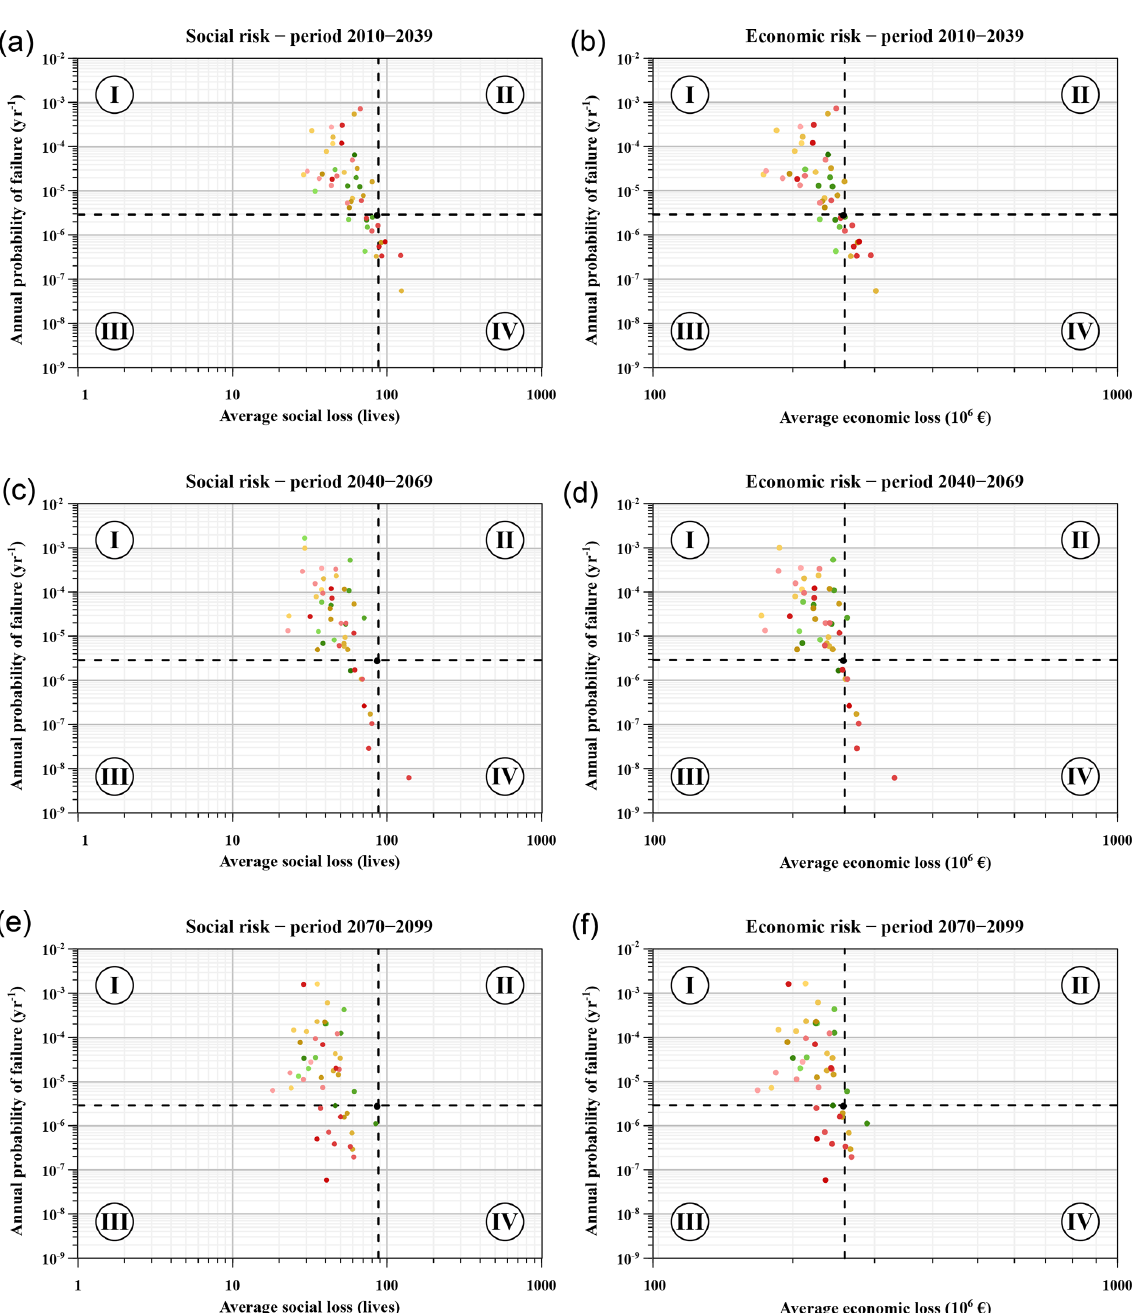
Figure 12. Disaggregation of social and economic risks ( a–f ) in annual probability of failure and average consequences, classified by simulation period. The same legend as in Fig. 11 is applied here for the points. The base case situation is highlighted with a black point and two dashed